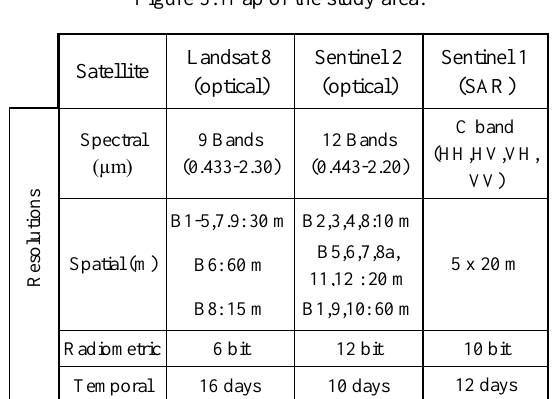
Figure 3. Map of the study area.